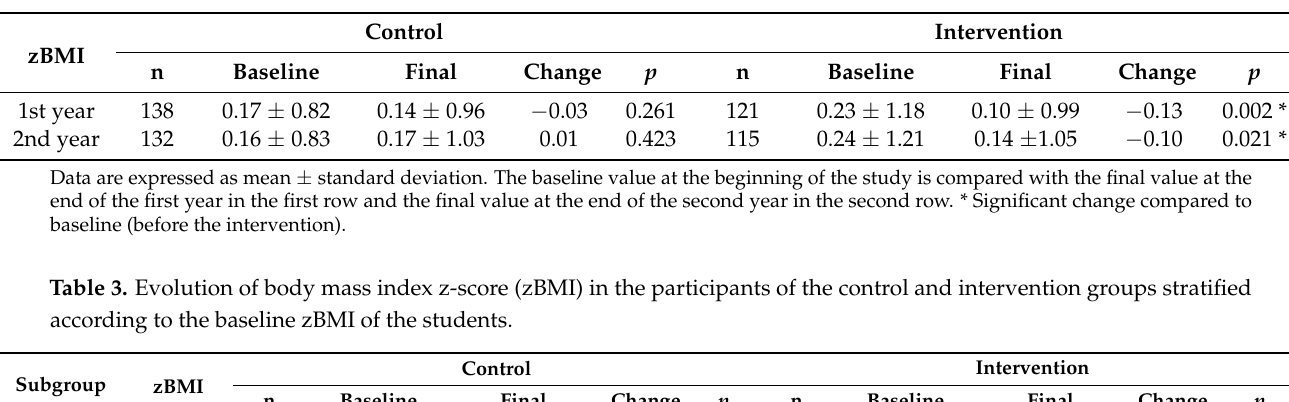
Table 2. Evolution of the body mass index z-score (zBMI) in the participants of the control and intervention groups during the study.